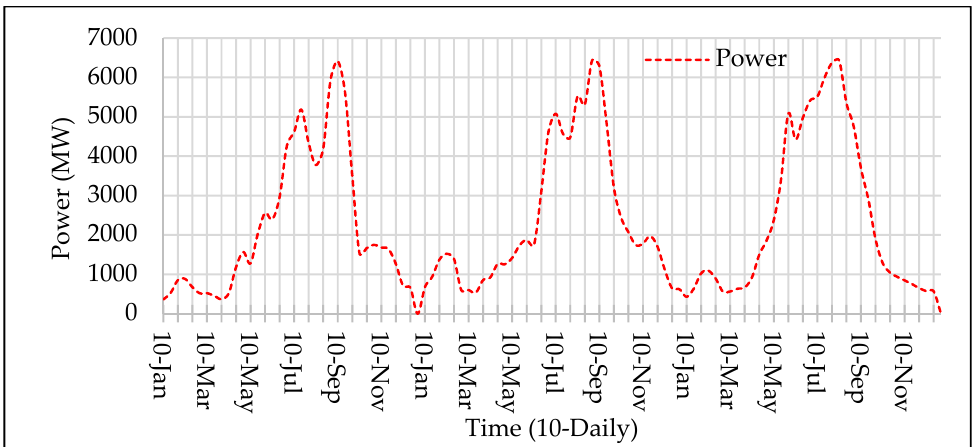
Figure 26. Power generation from Tarbela Reservoir for application years (2025, 2030 and 2035).